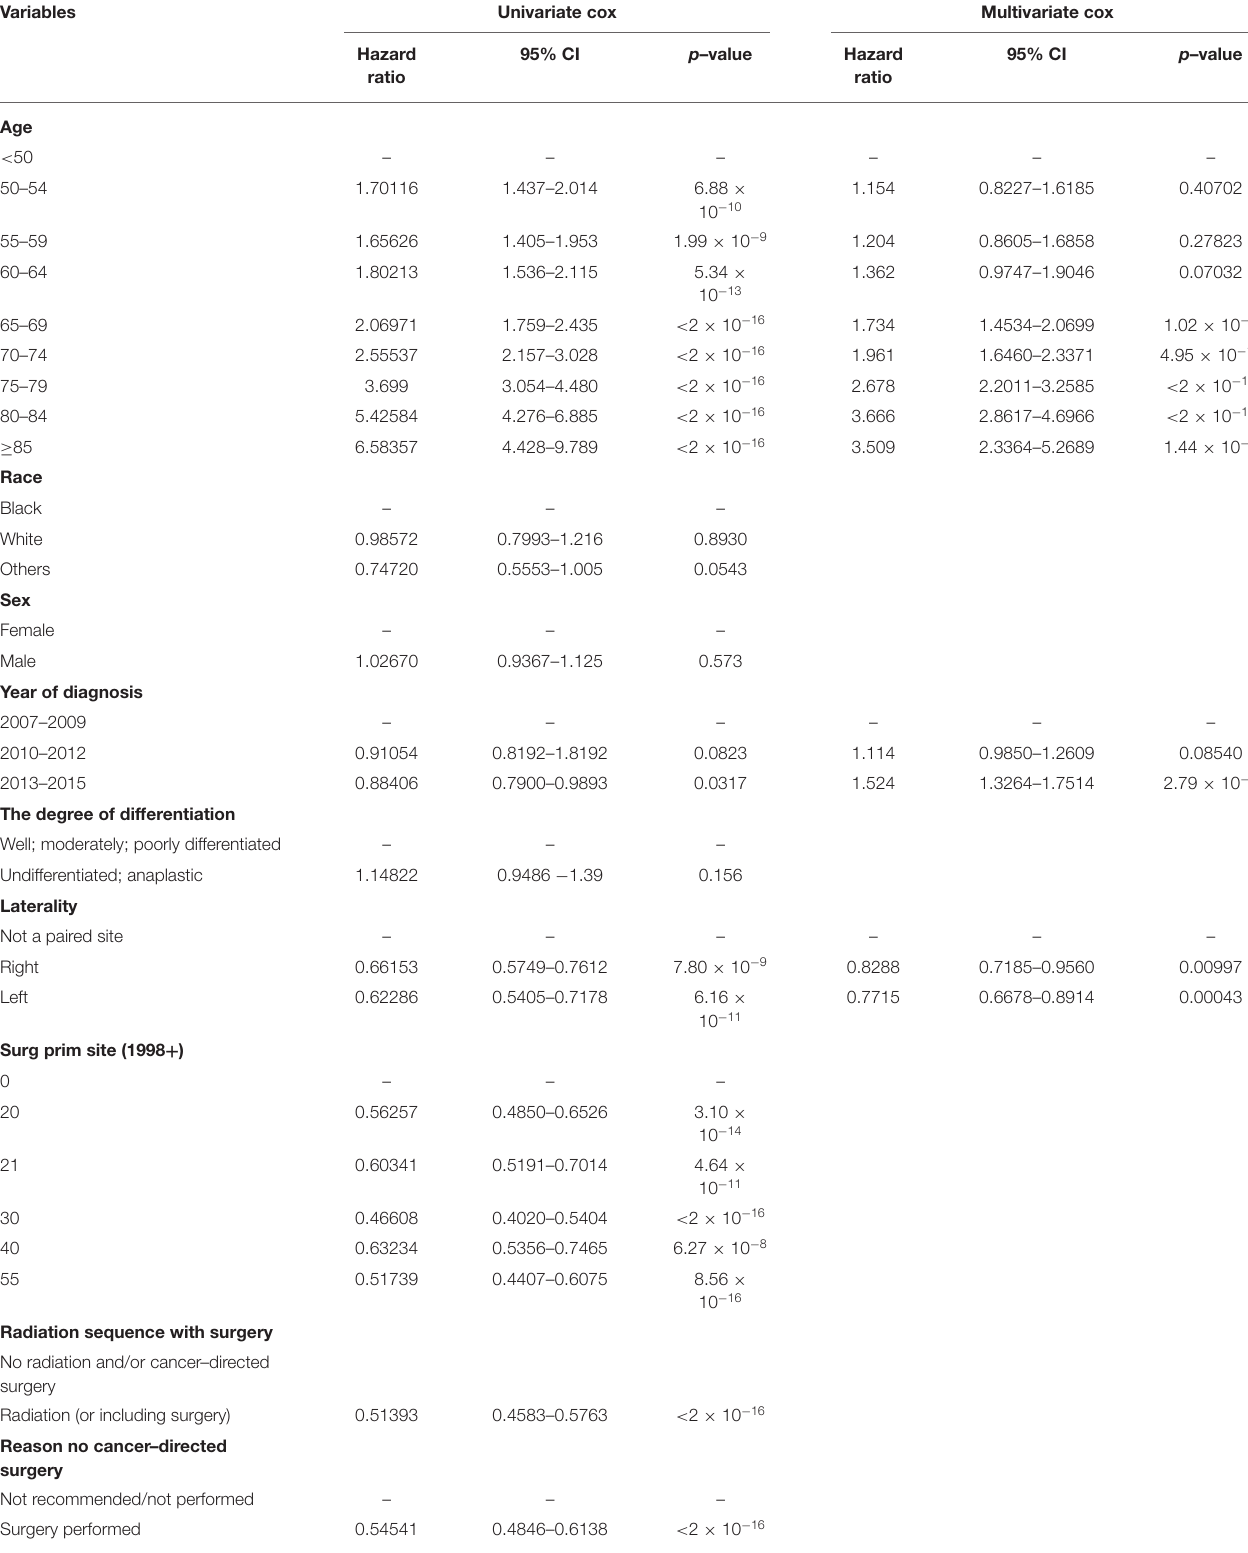
TABLE 3 | Univariate and multivariate analyses of prognostic parameter in glioblastoma using the Cox regression